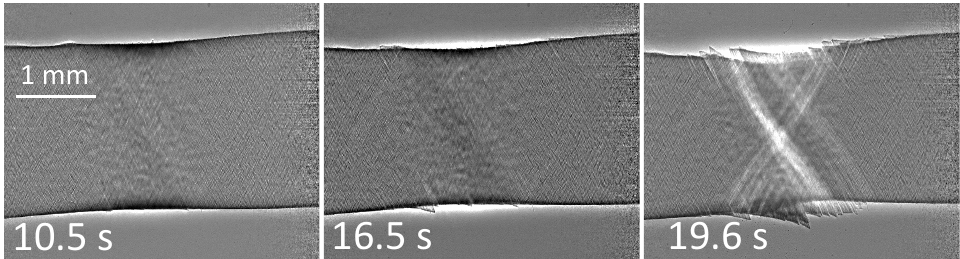
Figure 7. X-ray images of Basalt Fibre BFRP (fibre direction ± 45°) under tension in quasi-static UTM. Image series captured by Photron SA-Z high speed camera at 10 kHz frame rate and a resolution of 1024 × 1024 pixels. From left to right, different timestamps capturing the formation of crack to fracture. White contrast in these radiographs represent high intensity X-rays. The aspect ratio of the images are adjusted for illustration